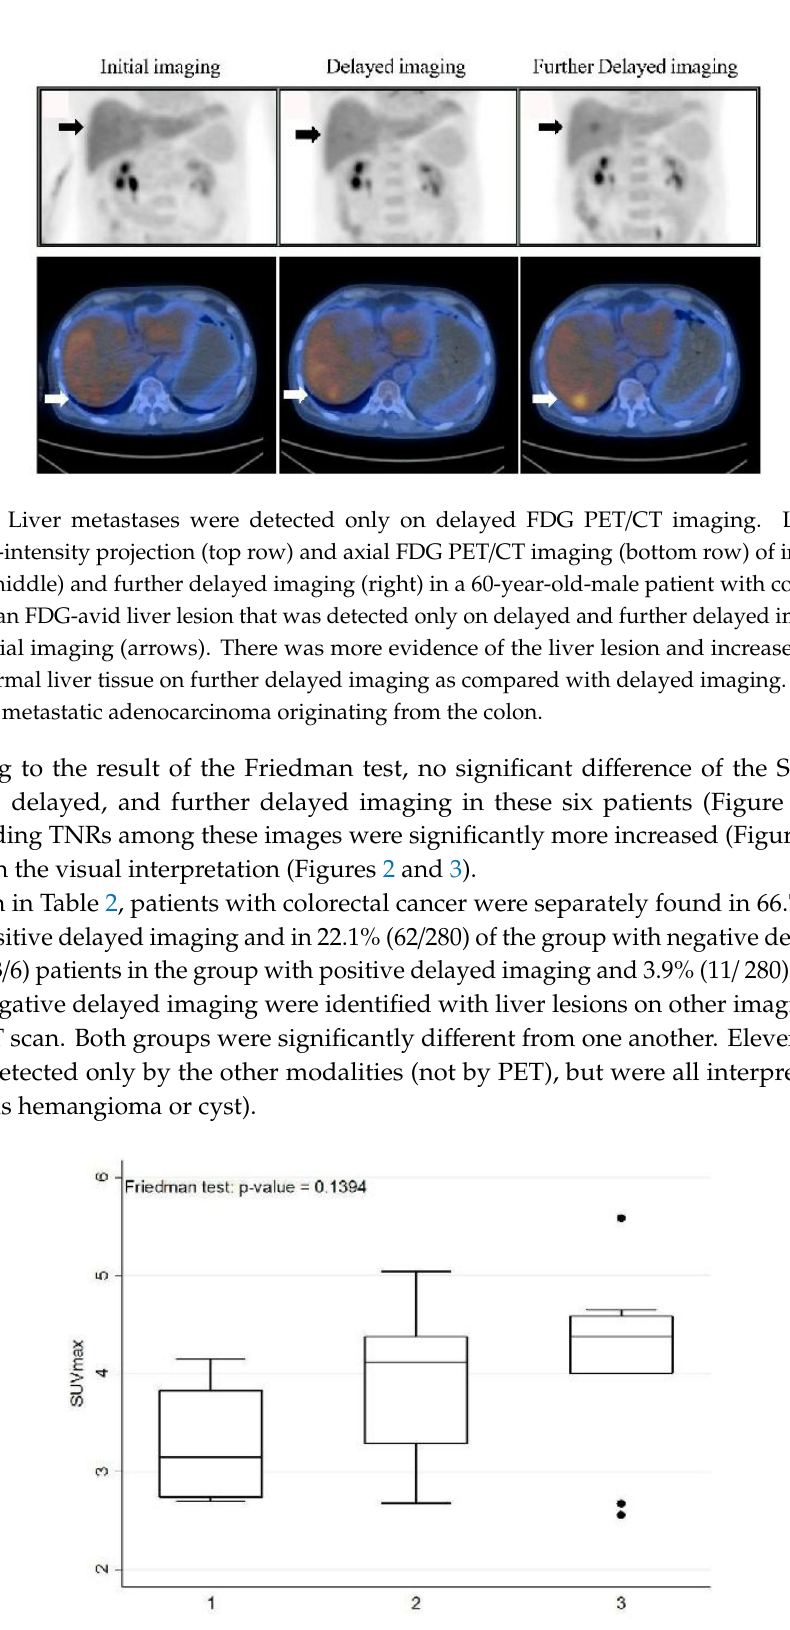
Figure 4. Box plot of SUV max on initial, delayed and further delayed PET / CT imaging. The x-axis represents three separate images: initial imaging = 1; delayed imaging = 2; further delayed imaging = 3. Friedman test: p -value = 0.1394. The SUV max values did not continue to increase with time and were not statistically